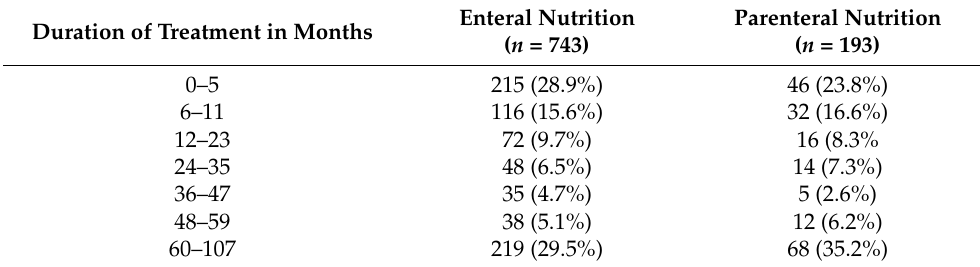
Table 4. Duration of treatment of patients starting the HEN and HPN procedures in